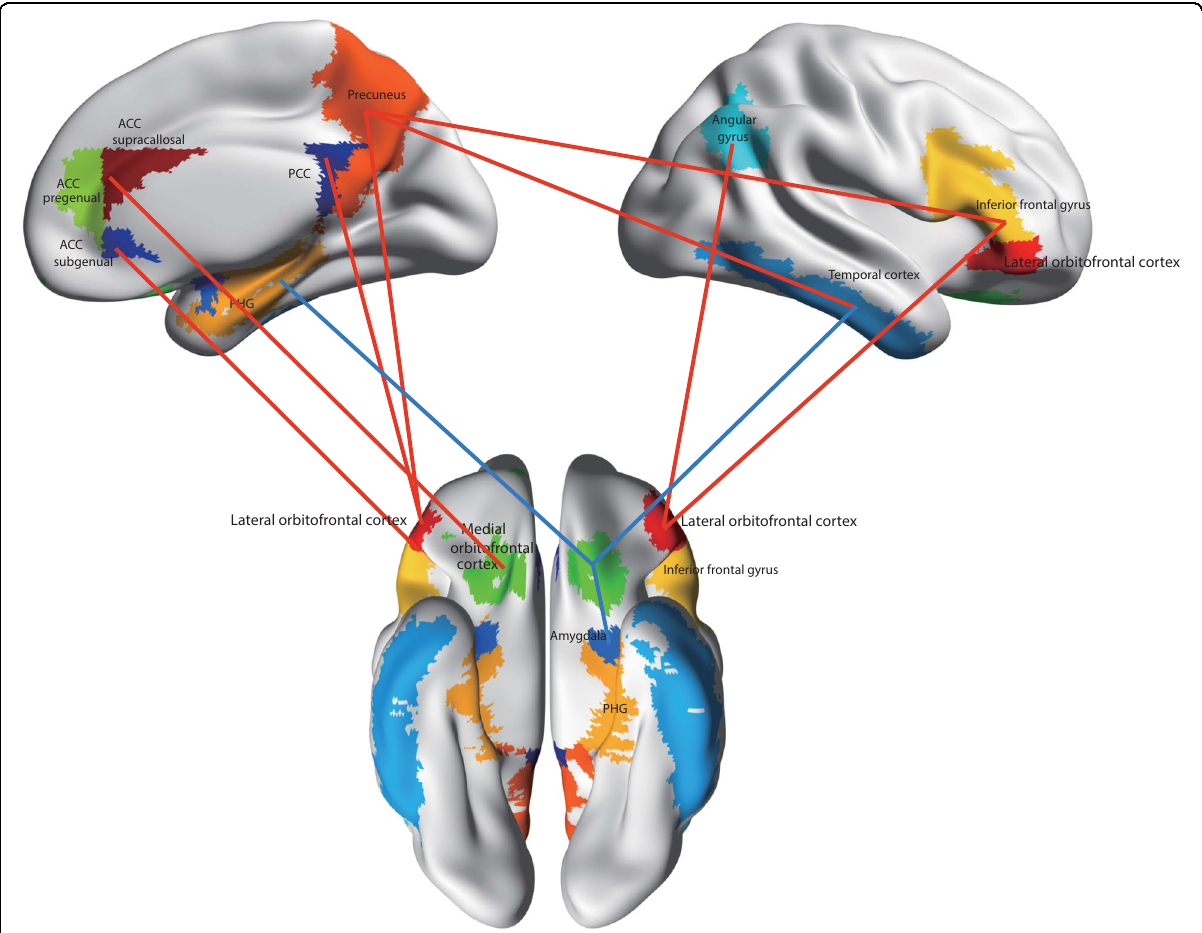
Fig. 8 Functional connectivity (FC) differences of the medial and lateral orbitofrontal cortex in major depressive disorder. Higher functional connectivity in depression is shown by red connecting lines and includes higher functional connectivity of the non-reward/punishment-related lateral orbitofrontal cortex with the precuneus, posterior cingulate cortex (PCC), pregenual anterior cingulate cortex (ACC), angular gyrus, and inferior frontal gyrus. Lower functional connectivity in depression is shown by blue connecting lines and includes lower functional connectivity of the medial orbitofrontal cortex with the parahippocampal gyrus memory system (PHG), amygdala, temporal cortex, and supracallosal anterior cingulate cortex (ACC). The part of the medial orbitofrontal cortex in which voxels were found with lower functional connectivity in depression is indicated in green. The areas apart from the medial orbitofrontal cortex shown are as de fi ned in the automated anatomical labeling atlas 124 , although the investigations that form the basis for the summary were at the voxel level. (After Rolls et al. 11